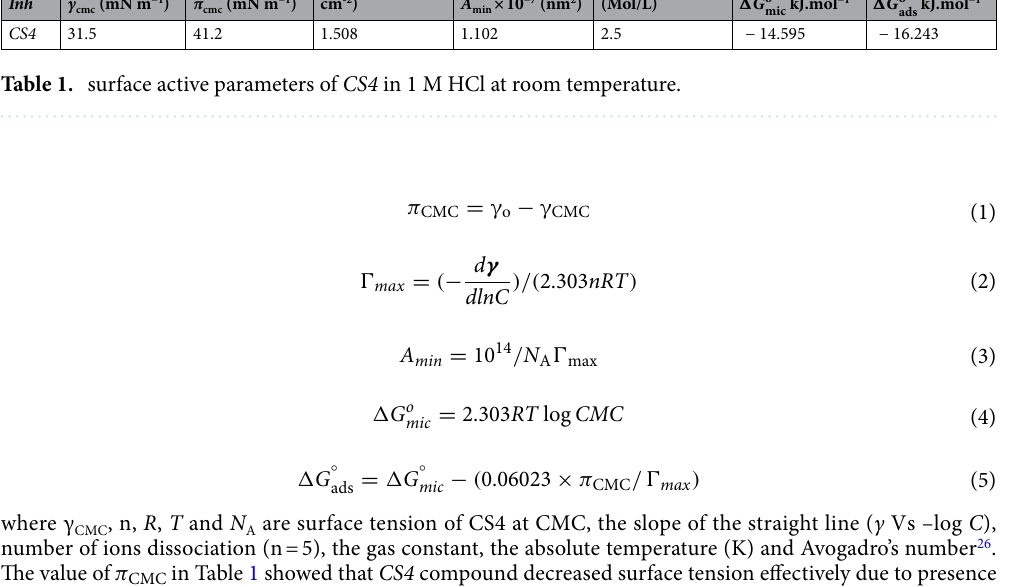
Table 1. surface active parameters of CS4 in 1 M HCl at room temperature.